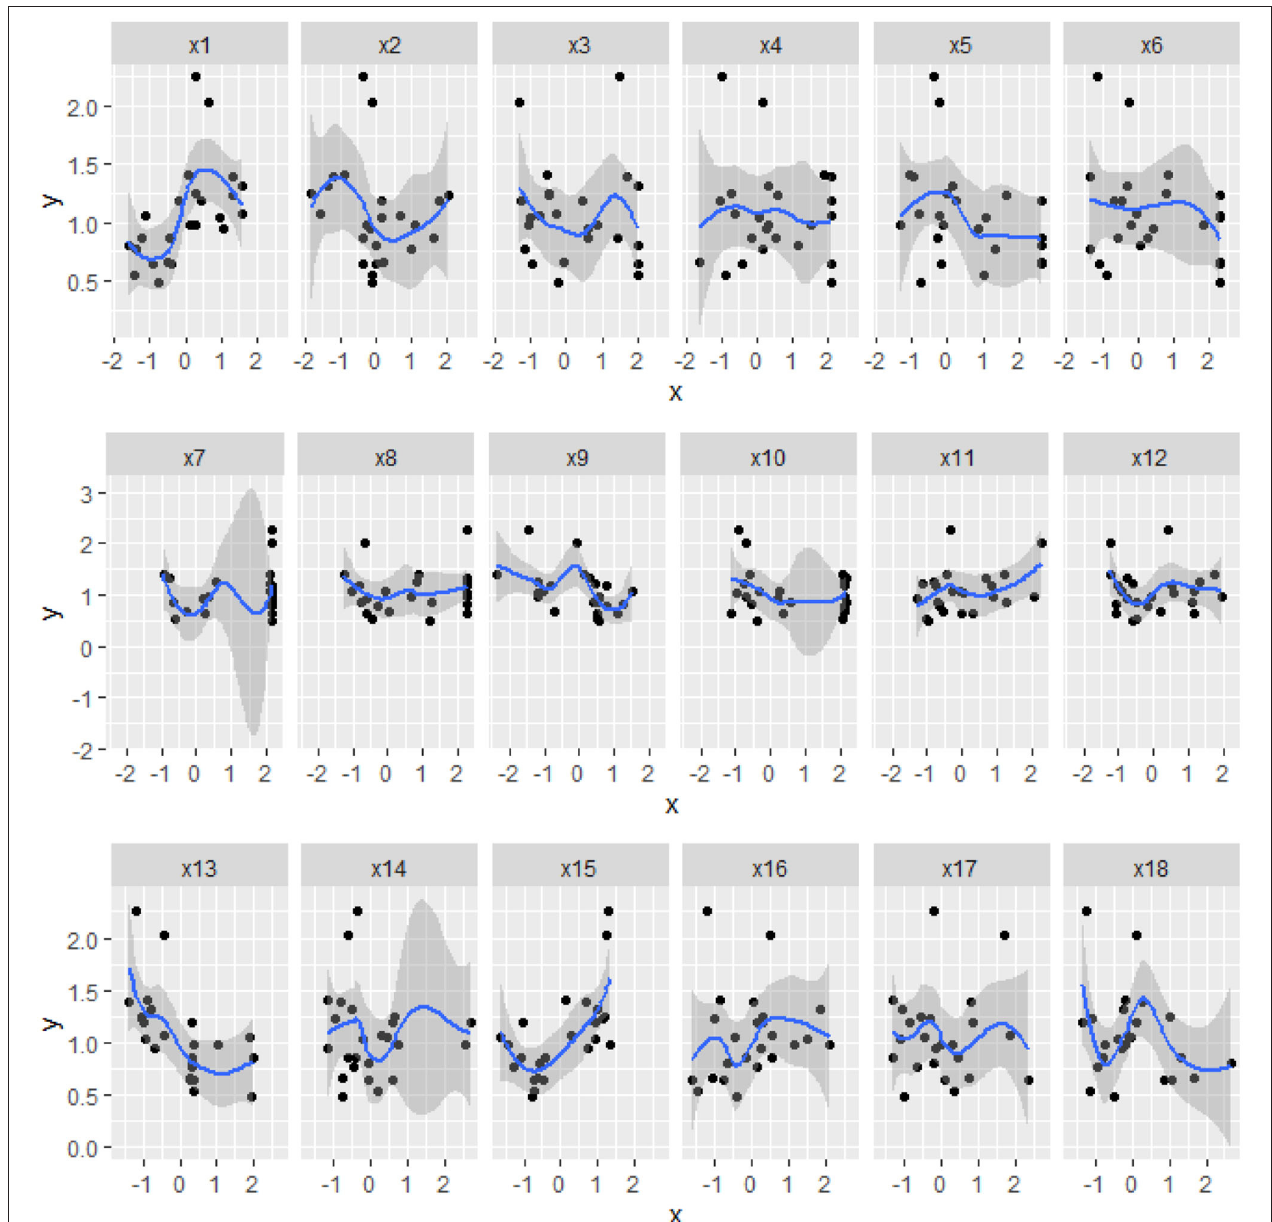
FIGURE 4 | The scatter and regression curves of the biomass and the physiological/biochemical indicators of S.miltiorrhiza . The horizontal axis of x i , is the physiological/biochemical indicator of i and the vertical axis is y , which is the biomass of S.miltiorrhiza . The blue curve is the regression curve, the shaded part indicates the confidence interval, and the larger the shaded area indicates the worse regression effect of the curve.